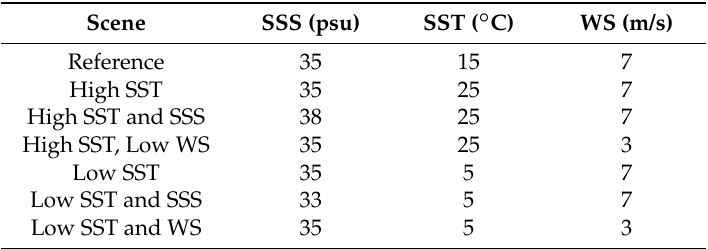
Table 3. The seven homogeneous scenes used in the